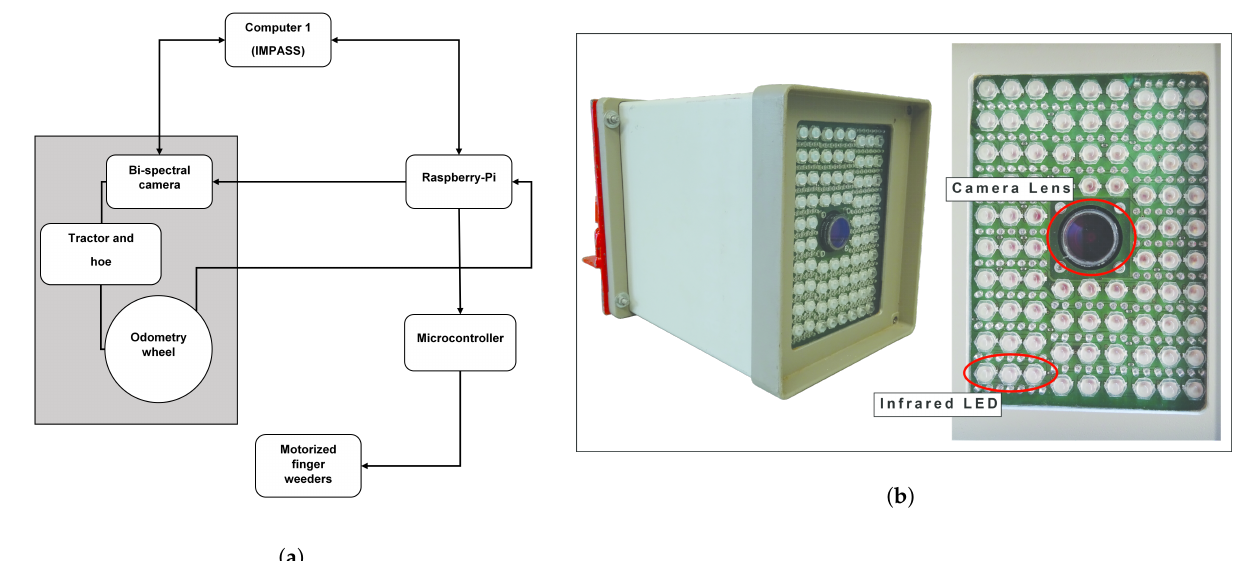
Figure 3. Sensor information. ( a ) Flowchart describing the sensor system. ( b ) The bi-spectral camera for intrarow weeding: the lens is surrounded by the infrared